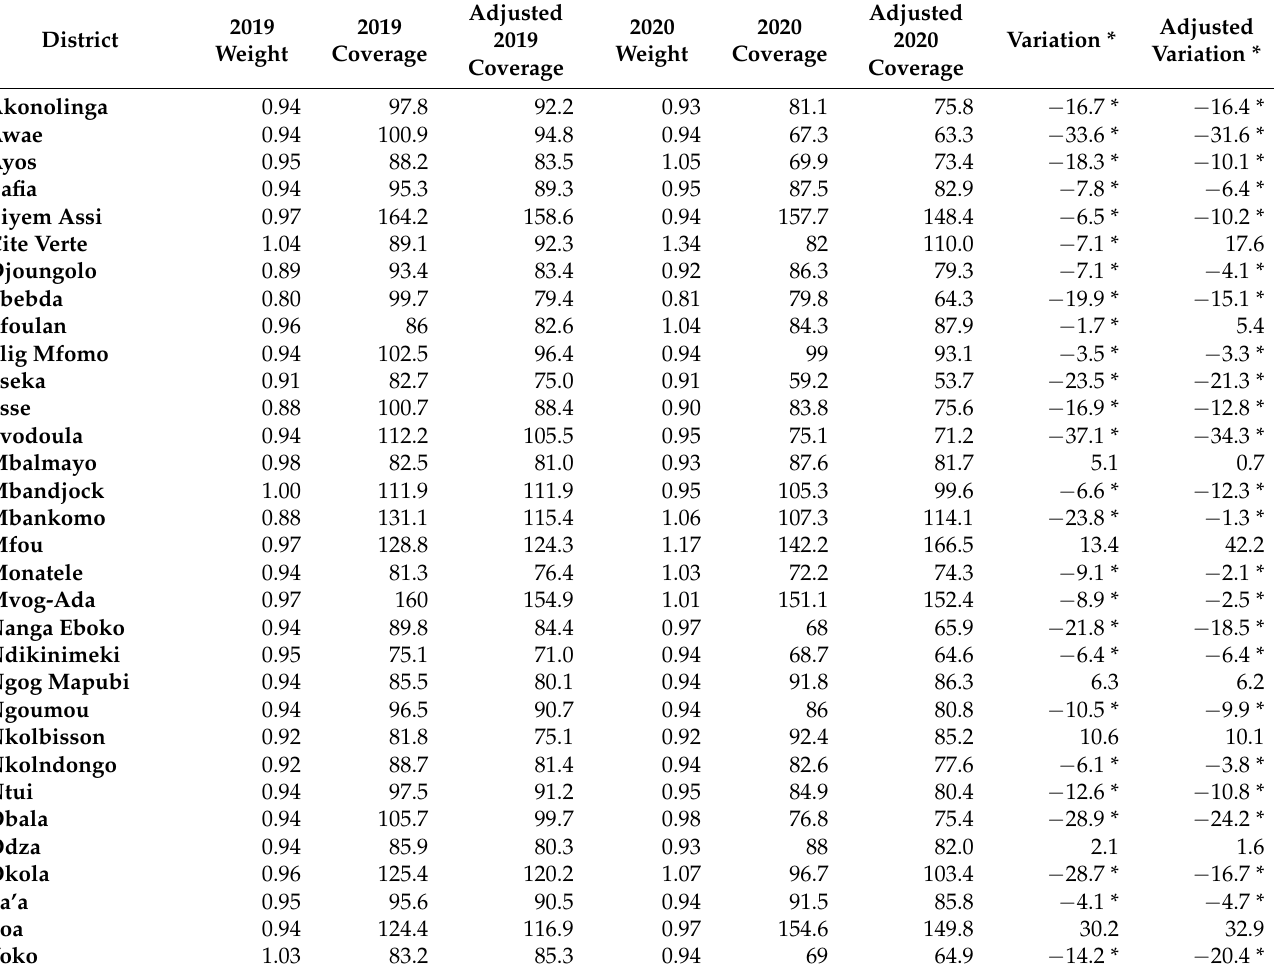
Table 3. DTP-1 coverage variations in the pre-pandemic and pandemic period in the Centre